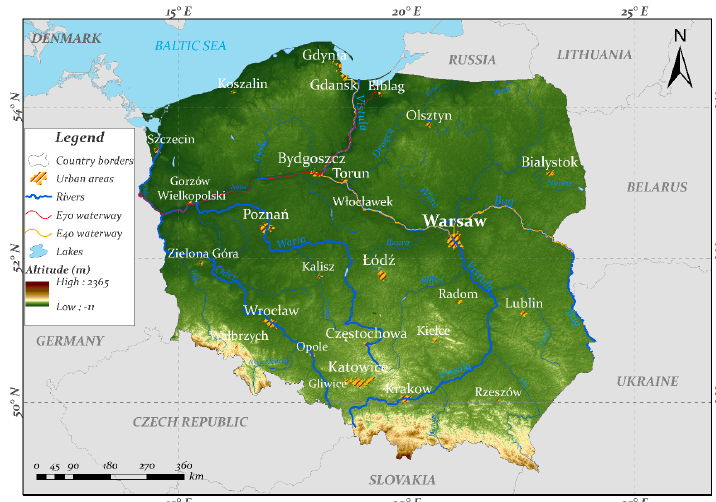
Water 2022 , 14 , x FOR PEER REVIEW